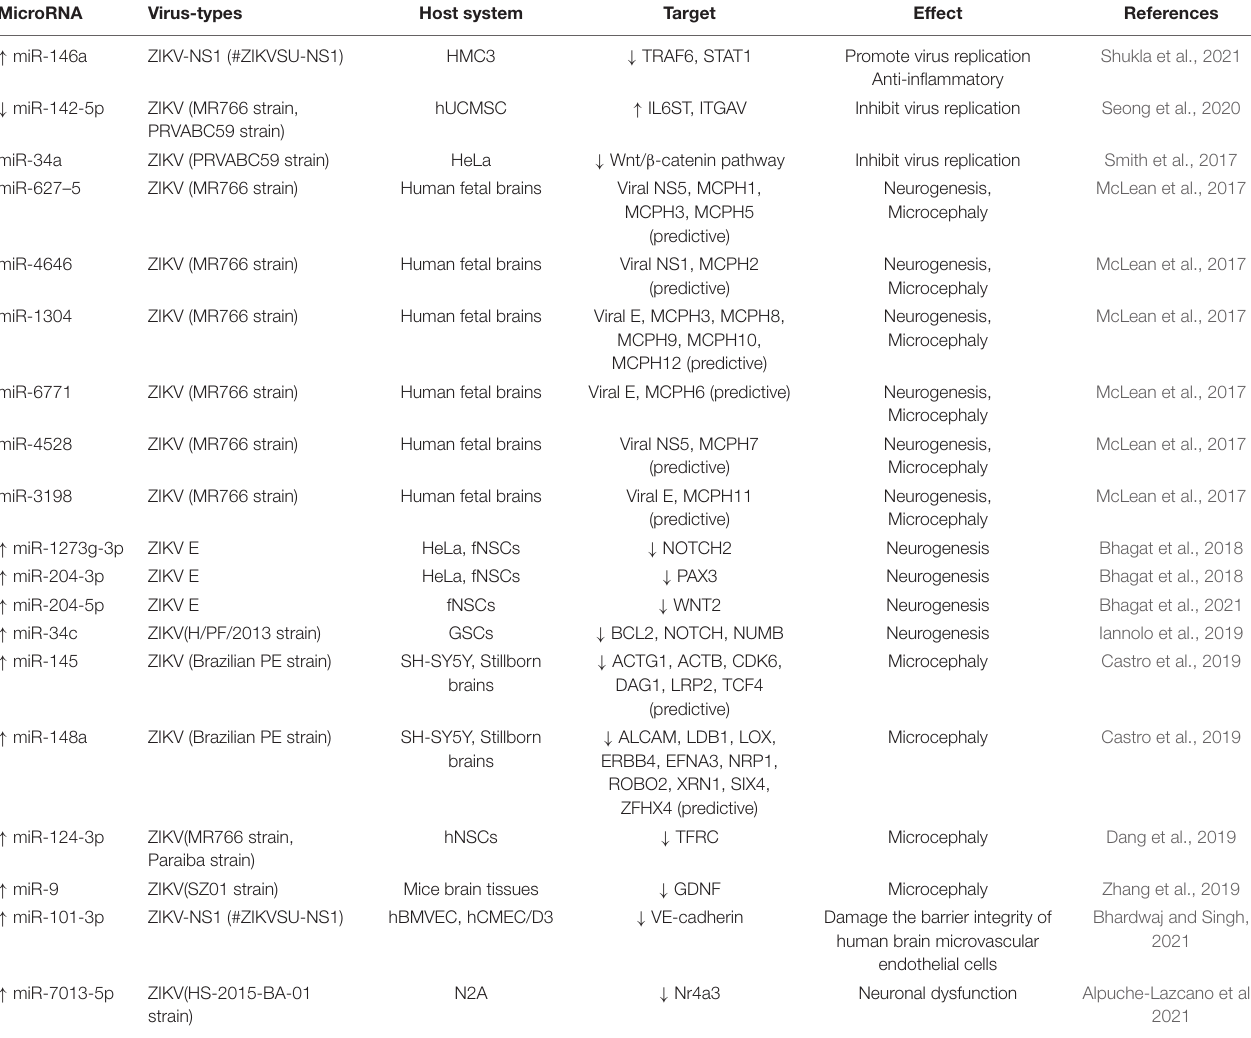
TABLE 4 | Differentially expressed miRNAs involved in ZIKV infection and their targets a